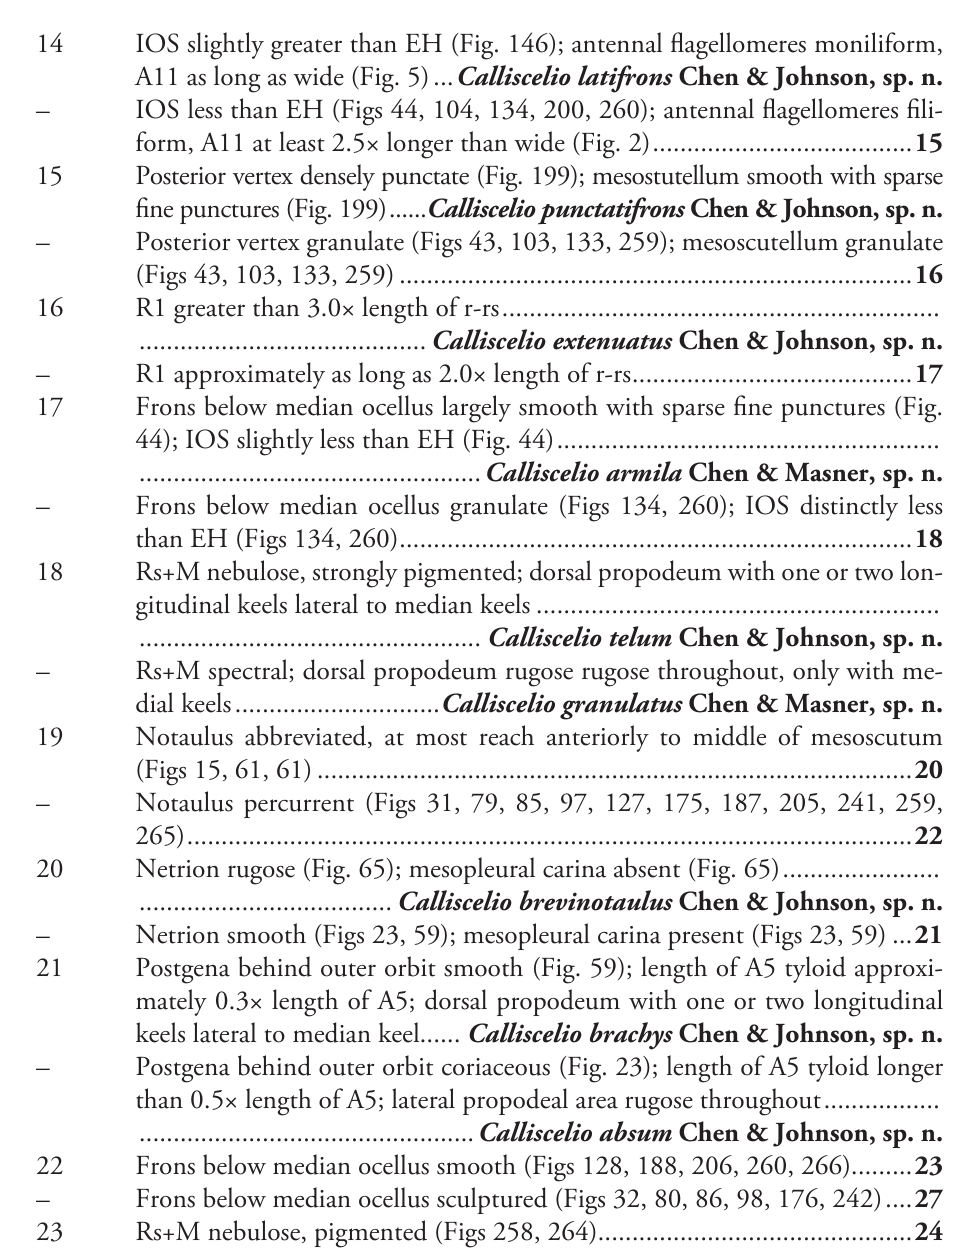
IOS slightly greater than EH (Fig. 146); antennal flagellomeres moniliform, A11 as long as wide (Fig. 5) ... Calliscelio latifrons Chen & Johnson, sp.